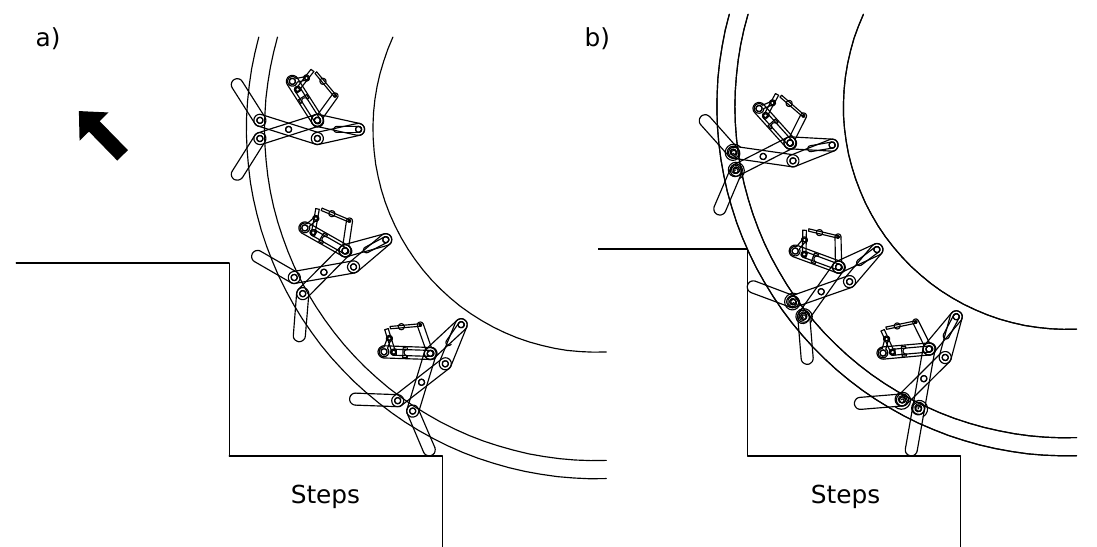
Figure 7. Schematic view showing the section of a wheel while ascending the stairs ( a ) without torsion spring at joint P 1 ; ( b ) with torsion spring at joint P 1 .